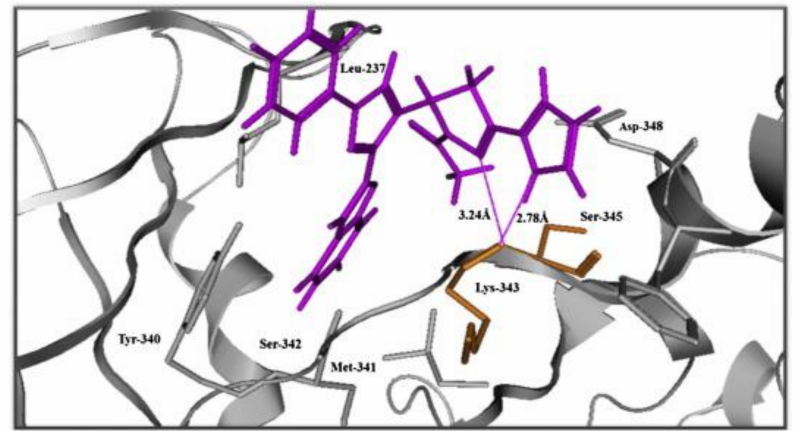
Figure 79. In silico binding interactions of compound 74 with Src crystal structure